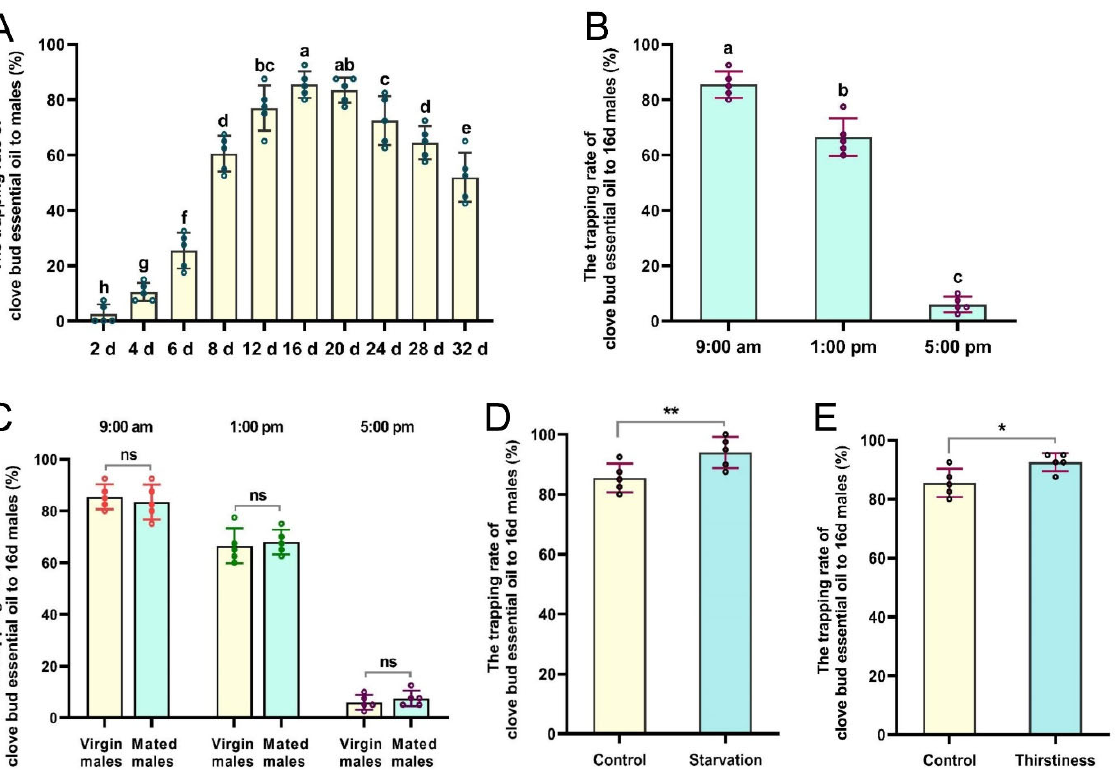
Figure 3. Responsiveness of Bactrocera dorsalis male flies to clove bud essential oil (CBEO): ( A ) Age ‐ related response of males to CBEO. ( B ) Diurnal pattern of mature virgin male responsiveness to CBEO. ( C ) Diurnal pattern of virgin and mated male responsiveness to CBEO. ( D , E ) Response of starved or thirsty males to CBEO. Each bar represents the mean ± SEM of five replicates. Different lowercase letters indicate significant differences (ANOVA, p < 0.05). Asterisks denote a significant difference between treatments ( t ‐ tests, p < 0.05). * p < 0.05, ** p < 0.01, ns = not significant ( p > 0.05).